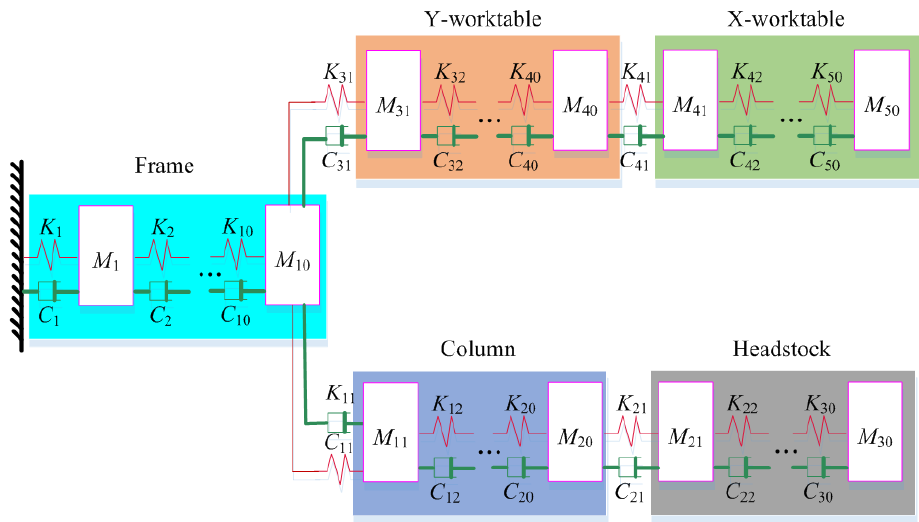
Figure 1. Schematic diagram of system simulation system.